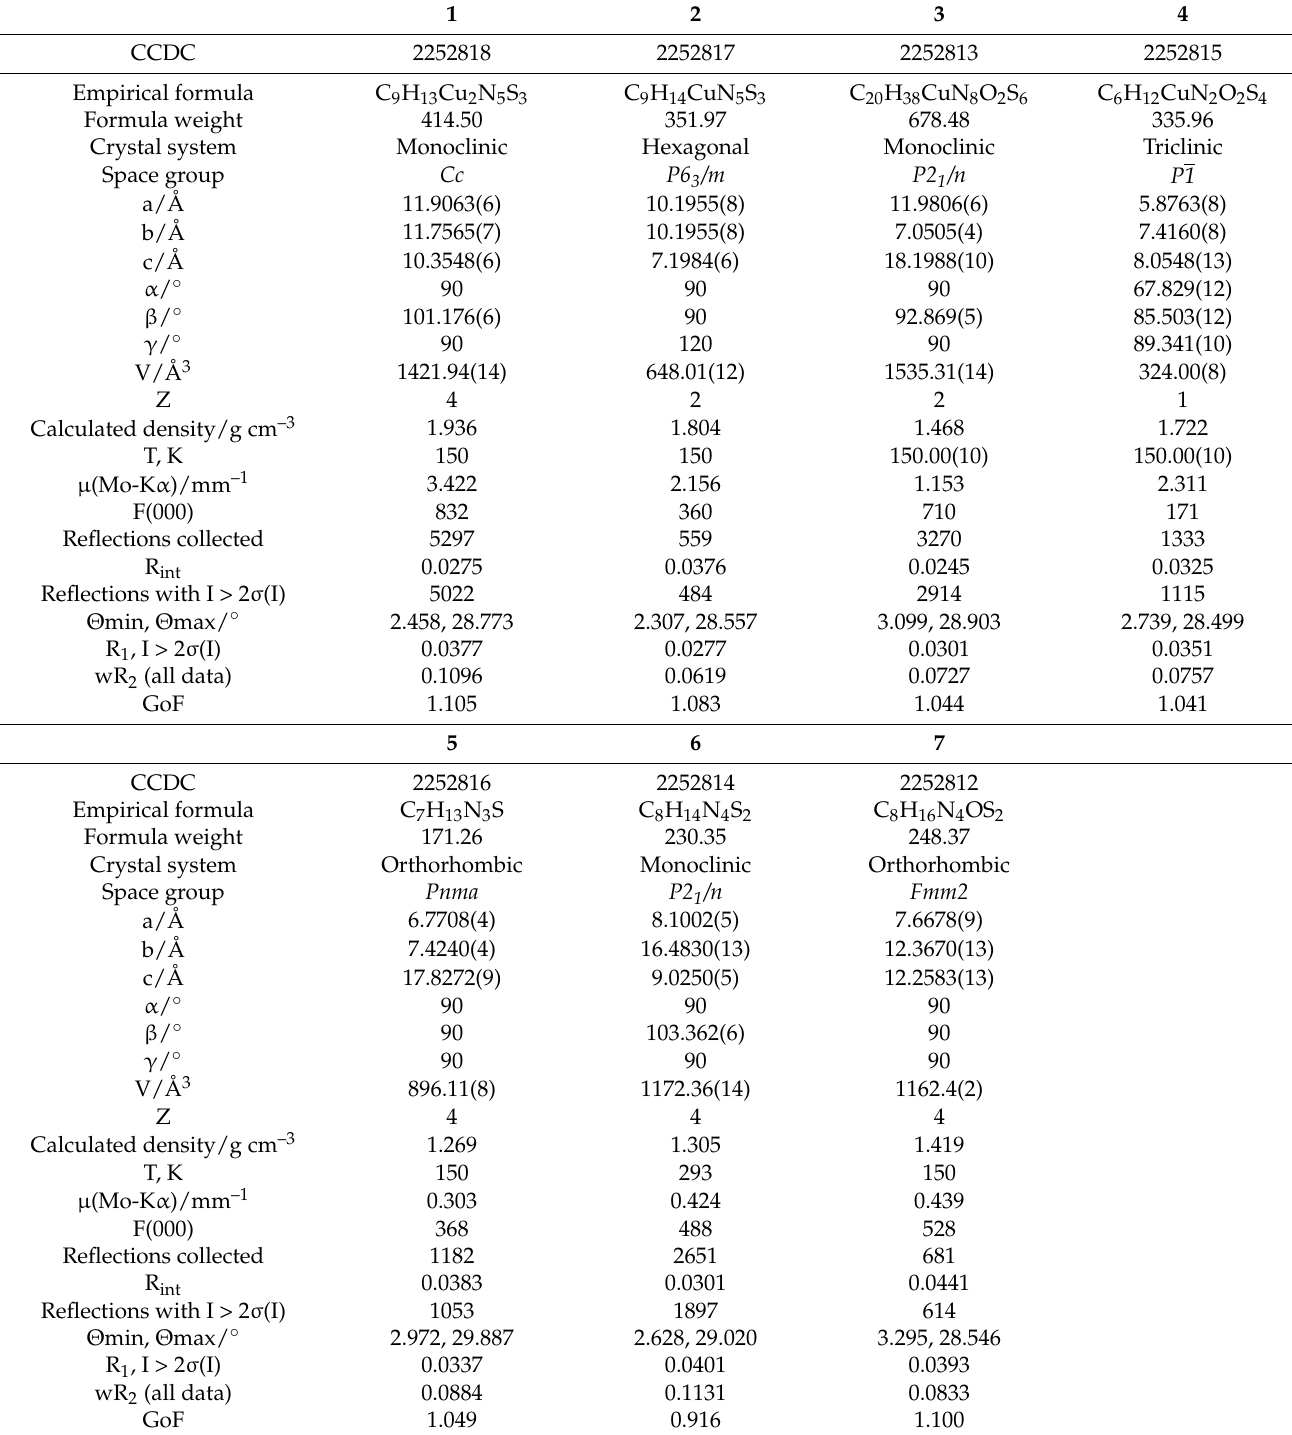
Table 1. Crystal data and structure refinement for 1 – 7